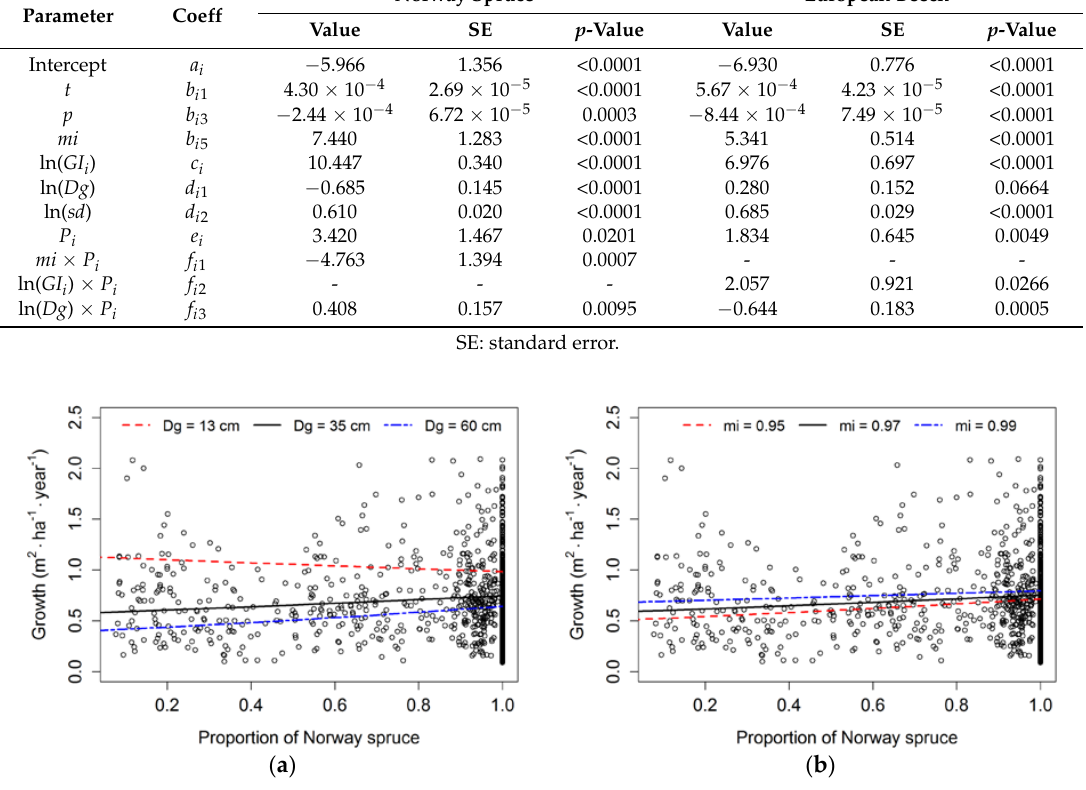
Figure 3. Effect of species proportion on Norway spruce basal area growth per unit species proportion ( a ) depending on the quadratic mean diameter and ( b ) depending on the moisture index. All the other explanatory variables are set to their mean values. mi: moisture index.